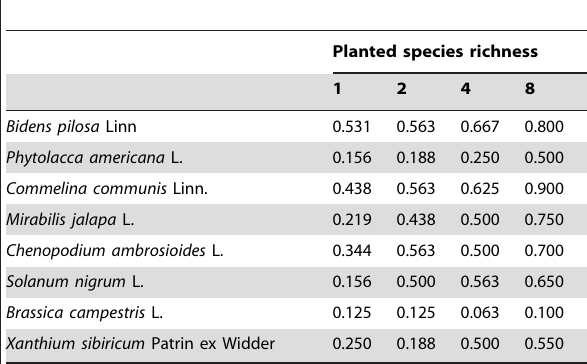
Table 4. The survival ratio of each planted species in certain species richness level.